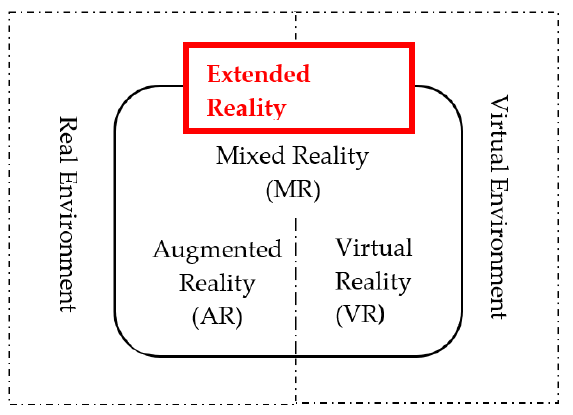
Figure 1. VR, AR, MR, and XR distinction.